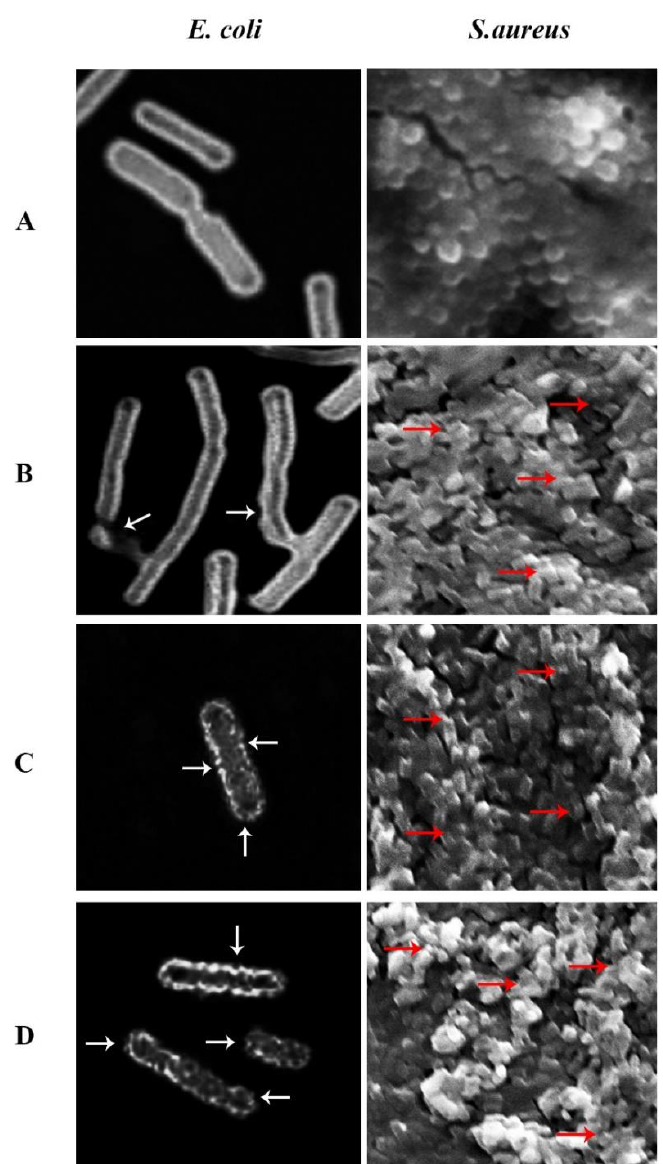
Figure 9. SEM images visualized the effect of GONPs, GONPs–PEG, and GONPs–PEG– N.sstiva on treated S.aureus and E.coli . The bacterial strains showed changes in the cell membranes like damaged, blabbed, and clumped membranes. Non-treated bacterial cell ( A ), bacterial cells treated with GONPs ( B ), with GONPs–PEG ( C ), and with GONPs–PEG– N.sativa ( D ).